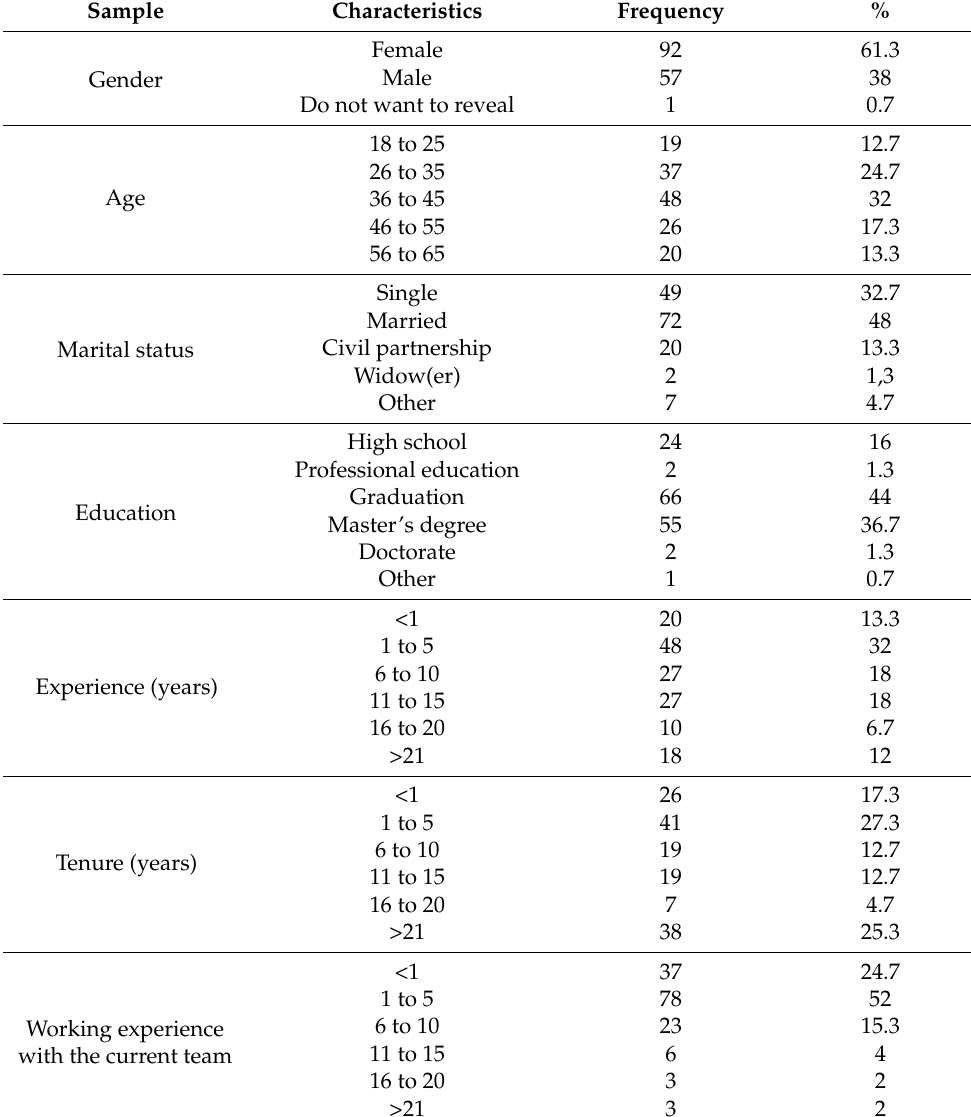
Table 1. Sample demographics ( n =